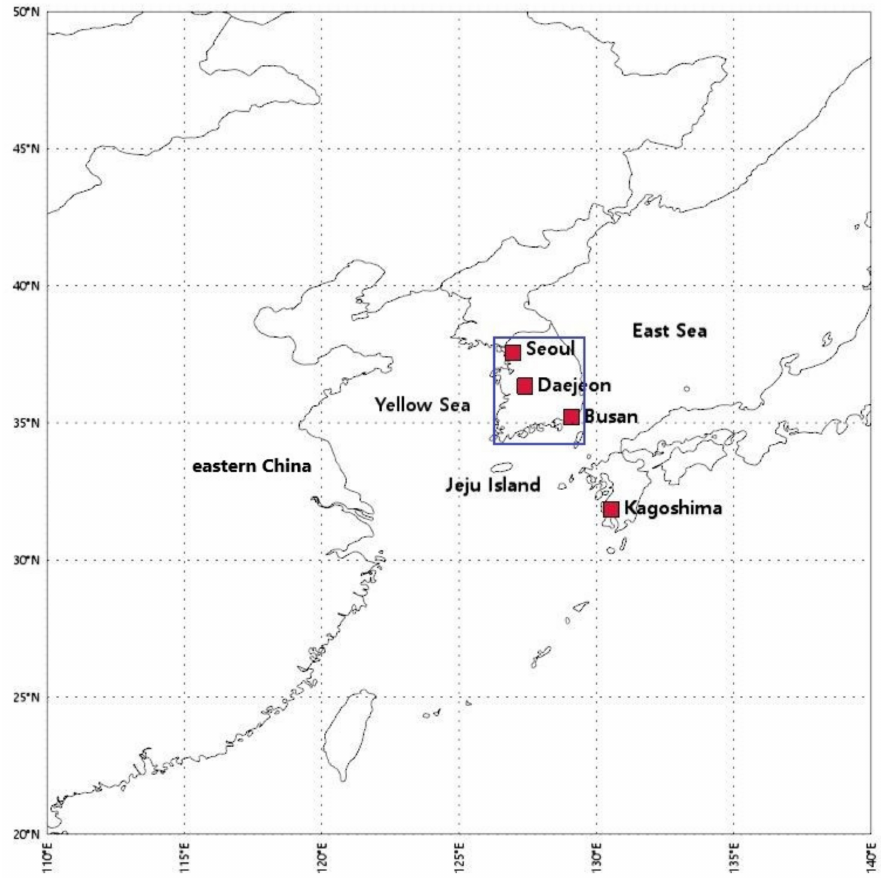
Figure 2. The GEOS-Chem simulation domain. All emissions inventory information was included in the first simulation, and the emissions inventory information for the area enclosed by the blue rectangle was excluded for the second